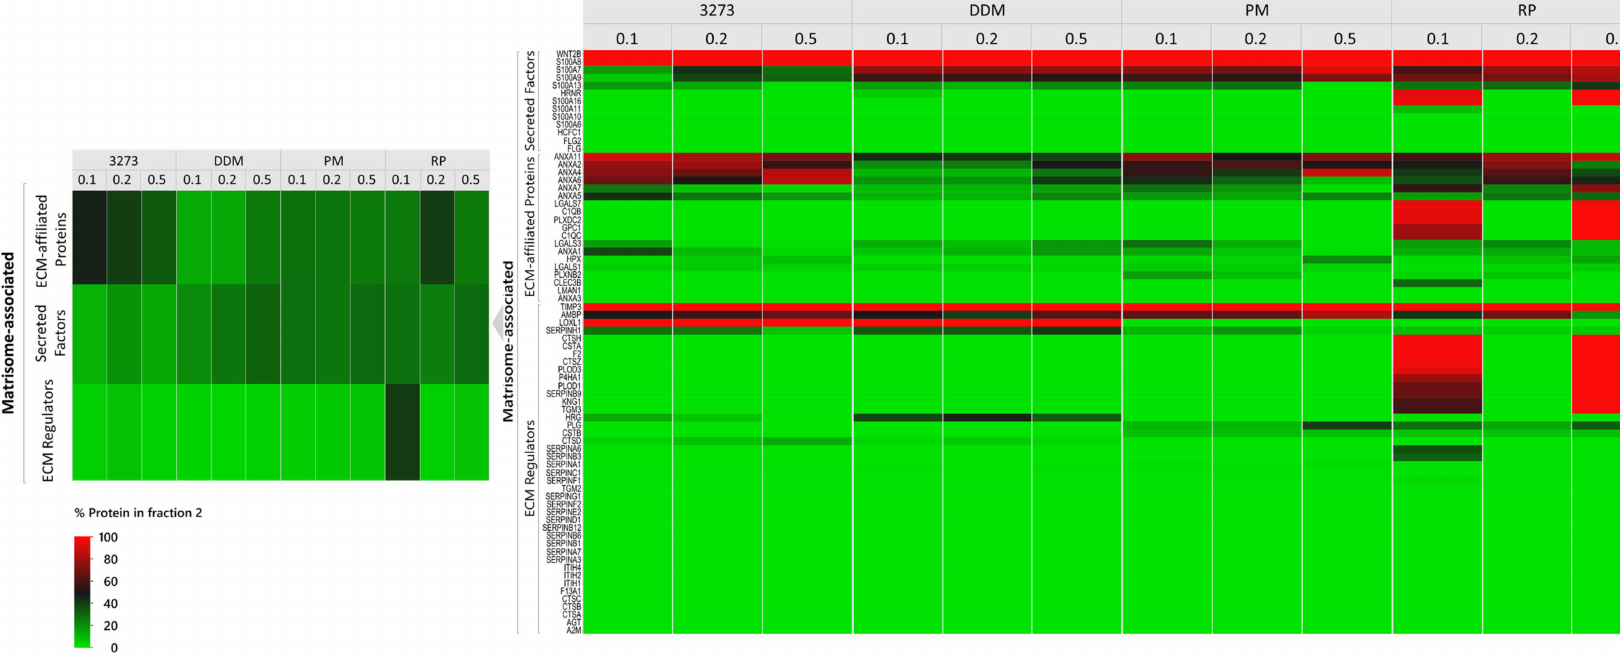
Figure 3. Heatmap of matrisome proteins detected in each condition. Protein abundance is expressed as the protein percentage detected in fraction 2 for each matrisome protein ( right side ) and averaged per category ( left side ). Proteins cited in the text are labeled with